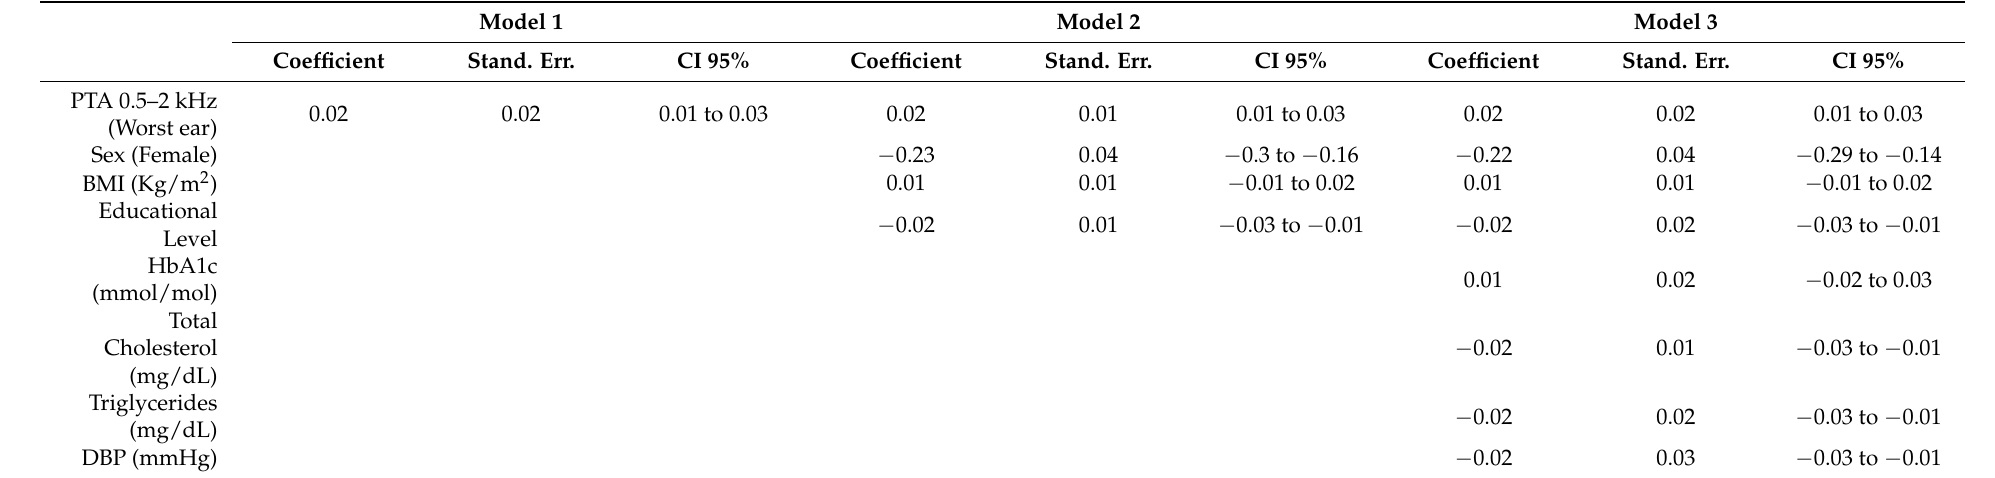
Table 2. Multiple rank-based regression models of FIB-4 score as dependent variable.